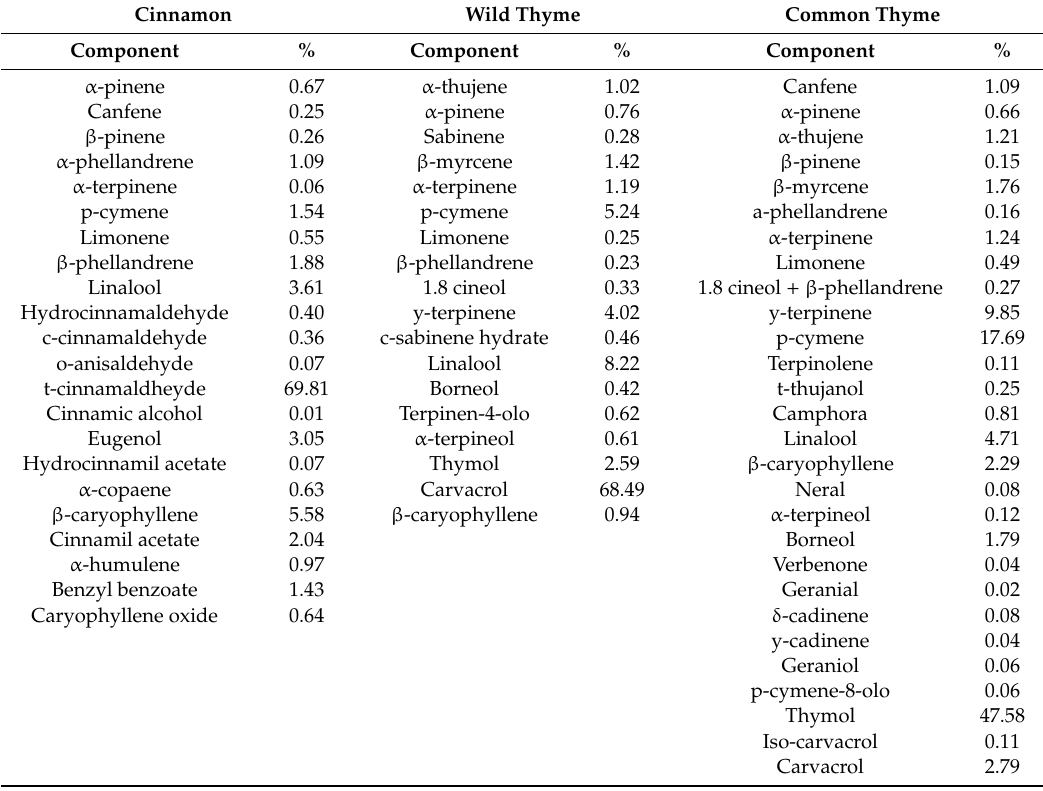
Table 1. Composition of the essential oils (EOs) selected for the experimentation. Cinnamon Wild Thyme Common Thyme Component % α